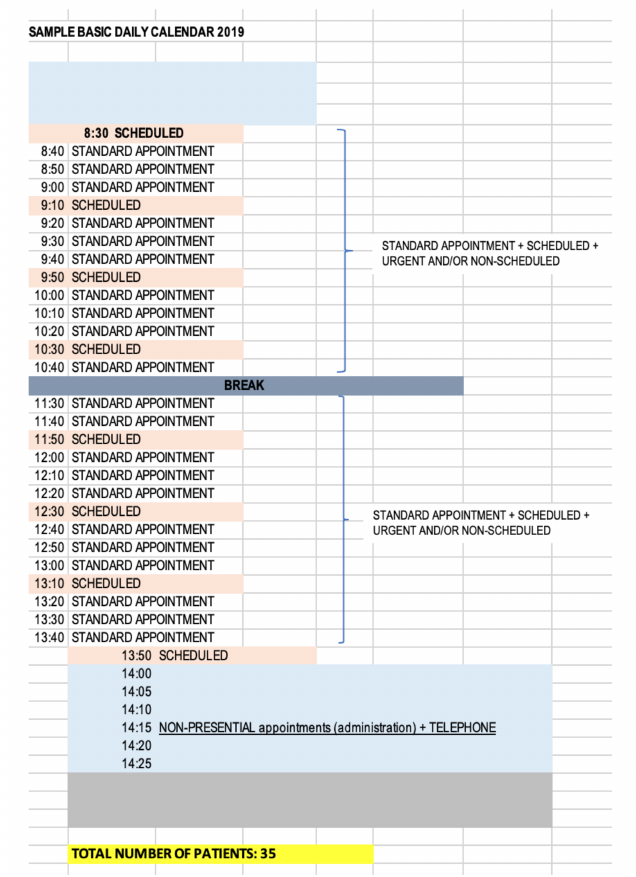
Figure 6. 2019 calendar.